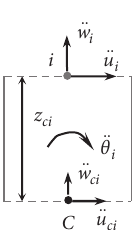
Figure 2: Accelerations of node i and centroid C of the investigated lump.